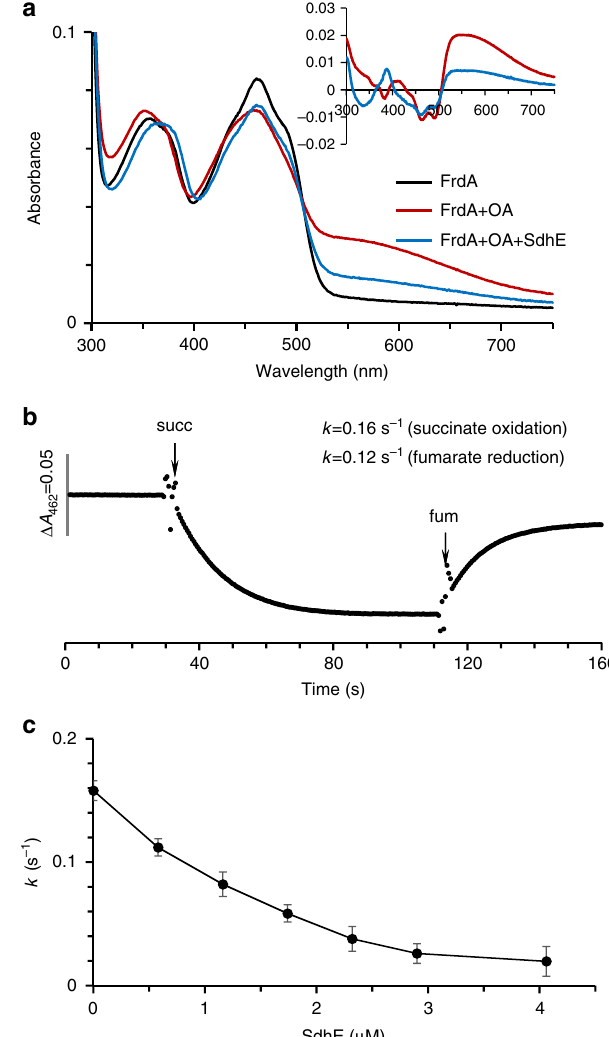
Fig. 4 Effect of SdhE on dicarboxylate orientation and succinate oxidase activity of FrdA. a Optical binding spectrum of FrdA and the FrdA-SdhE assembly intermediate with oxaloacetate. The absorbance spectrum of puri fi ed, isolated FrdA (9.8 µ M) is shown in black. The addition of oxaloacetate (0.2 mM, red line) induces broad spectral changes. As can be seen in the inset, the difference spectrum (FrdA – ligand complex minus free FrdA) exhibits a broad peak characteristic for a charge transfer complex. Addition of SdhE (19.5 µ M, blue line) decreases the absorbance of the oxaloacetate-induced charge transfer complex, with signi fi cantly reduced charge transfer complex observed in the difference spectrum. b Representative succinate oxidation and fumarate reduction by FrdA subunits (9.8 µ M). Absorption at 462nm corresponds to oxidized FAD. Succinate oxidation was monitored by following the decrease in absorbance of the FAD cofactor at 462 nm upon addition of 5 mM succinate, and fumarate reduction was followed by the increase in absorbance at 462 nm upon addition of 5 mM fumarate, as described in “ Methods ” . c SdhE inhibition of the succinate-DCIP-reductase reaction catalyzed by FrdA (0.45 µ M). The data report the mean of the experiment with the error bars indicative of the variation from experiments. Data in a – c are representative from three or more analyses. All analyses were done at pH 8.0; optical spectra were collected at 25 °C, catalysis was performed at 30